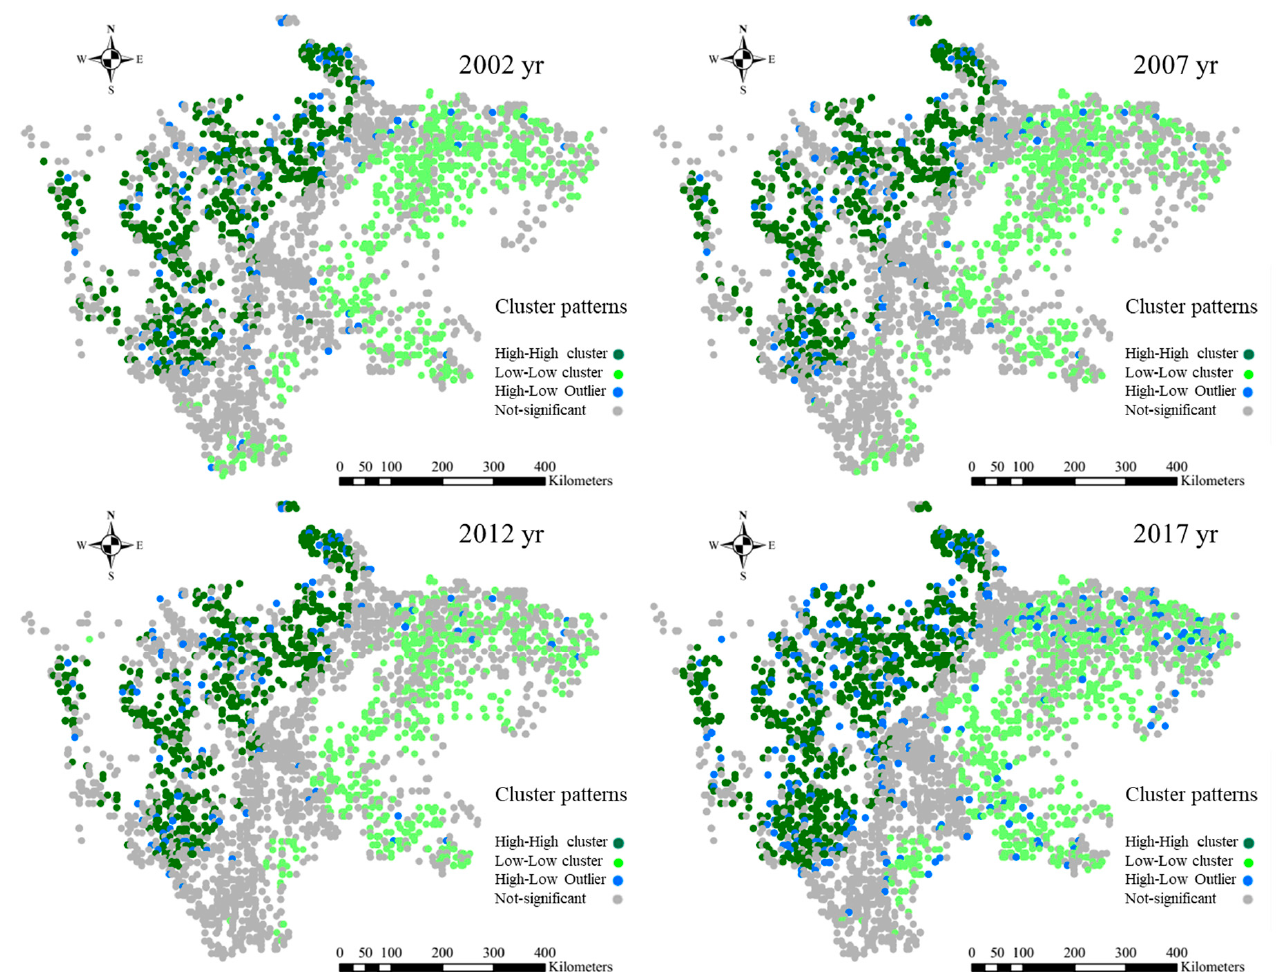
Figure 4. Spatial clustering pattern of the forest volume for each of the 5-year intervals. Table 1. Statistical results of the spatial cluster pattern information regarding the forest